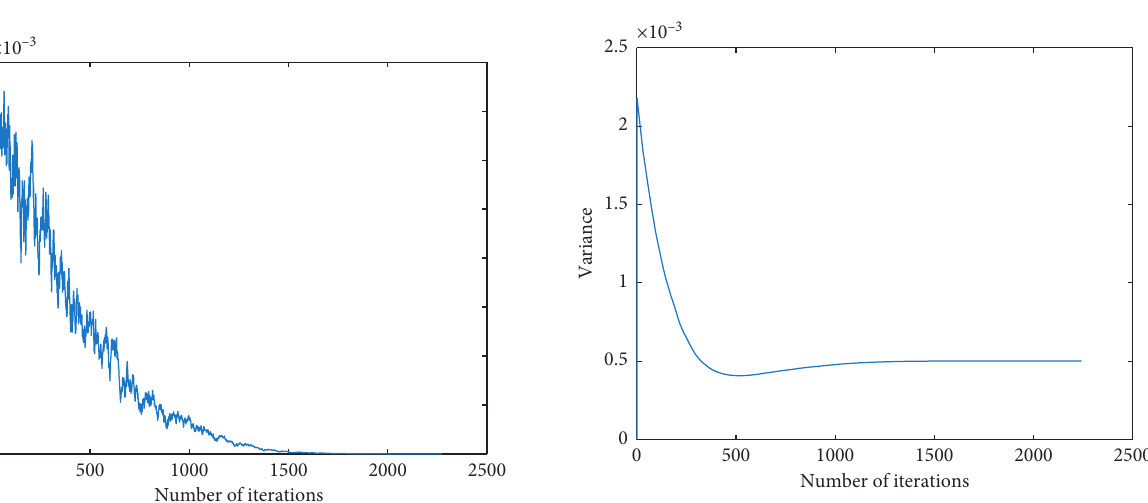
Figure 8: Changes in the variance of Adam algorithm.